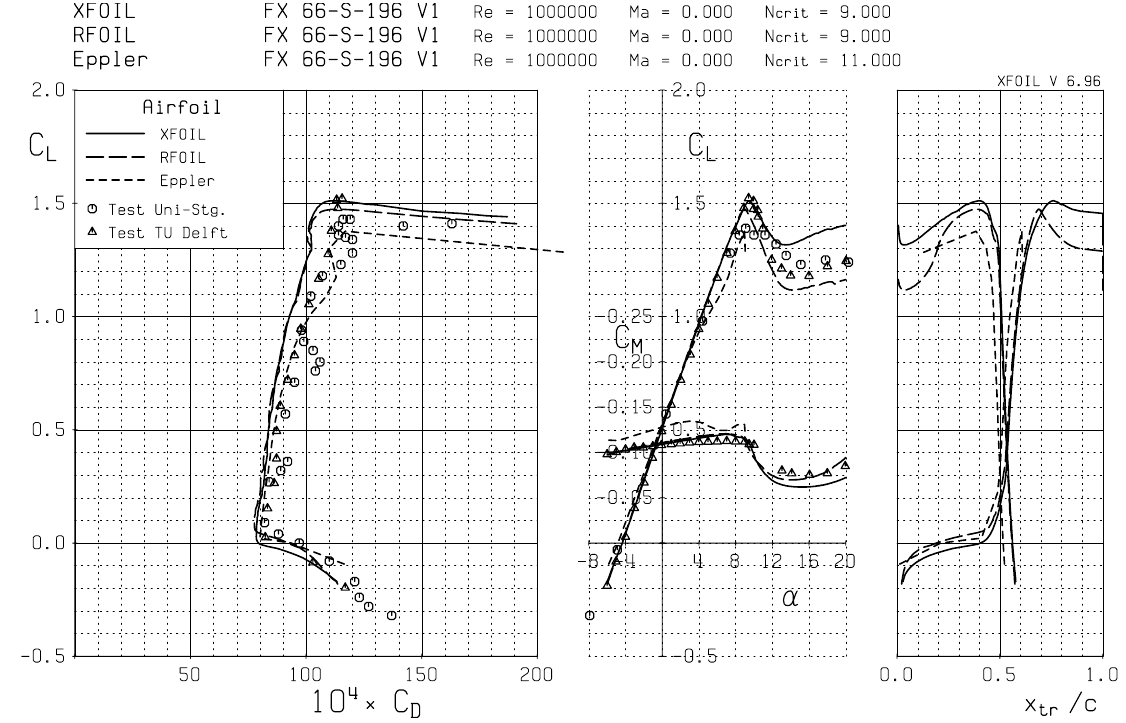
Fig 4. Comparison of calculated and measured data of FX 66-S-196VI airfoil at Re = 1·10